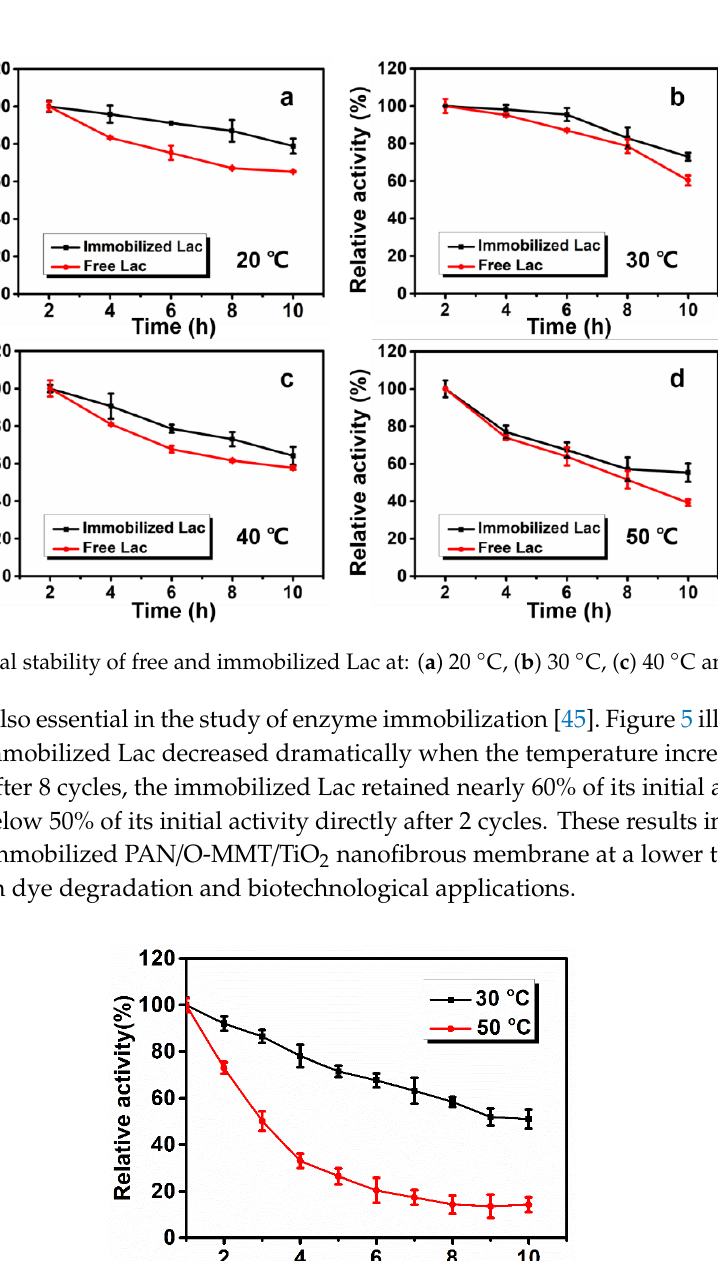
Figure 5. Operational stability of immobilized Lac enzyme at 30 °C and 50 °C.